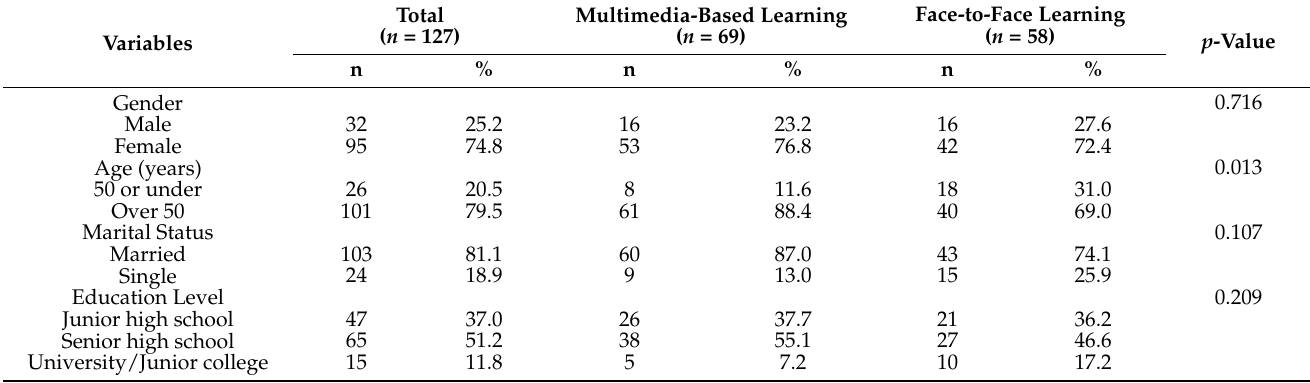
Table 1. Distributions of demographic characteristics of the study